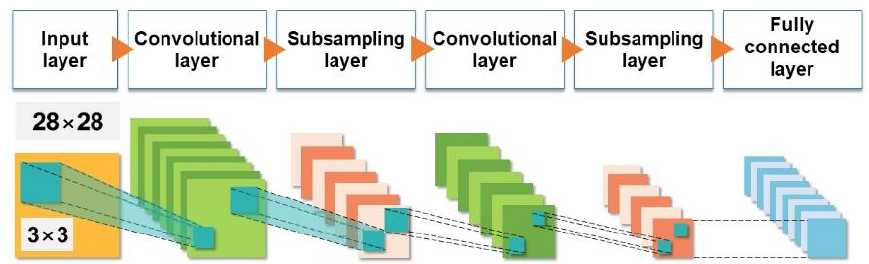
Figure 1. Schematic overview of a generalised convolutional neural network. Source: Sezer et al.